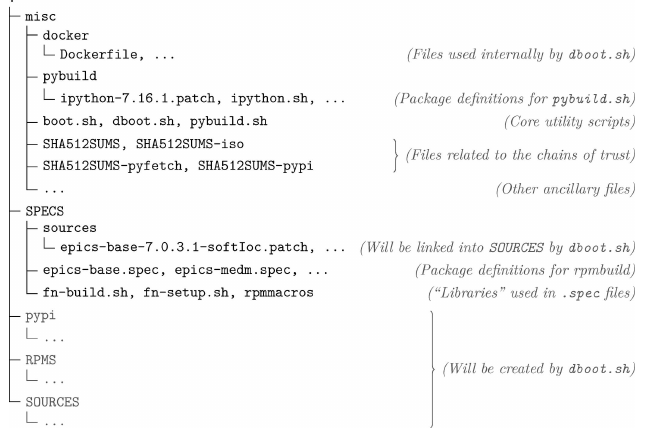
Figure 1 Directory layout of our packaging system.